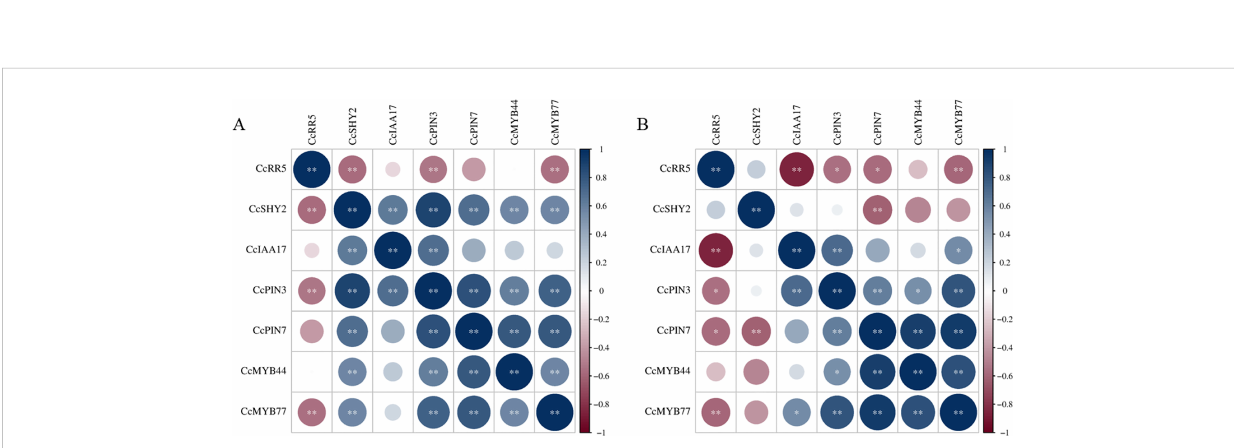
FIGURE 9 The correlation between expressions of CcRR5 and root-related genes in the leaves (A) and roots (B) of CcRR5 transgenic plants. The color bar represented the range of correlation coef fi cient ( r ). * p < 0.05; ** p <